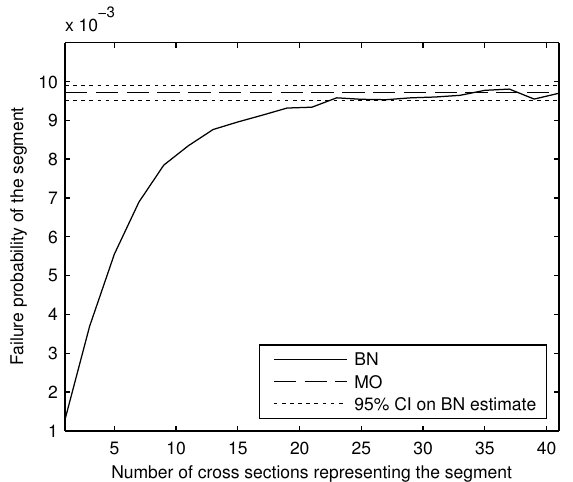
Figure 12. Comparison of the BN with the modified outcrossing (MO) estimate, for Z = R 1 + R 2 − S , with R 1 and R 2 lognormally distributed, and S Gumbel-distributed, prior to incorporating a survival observation.